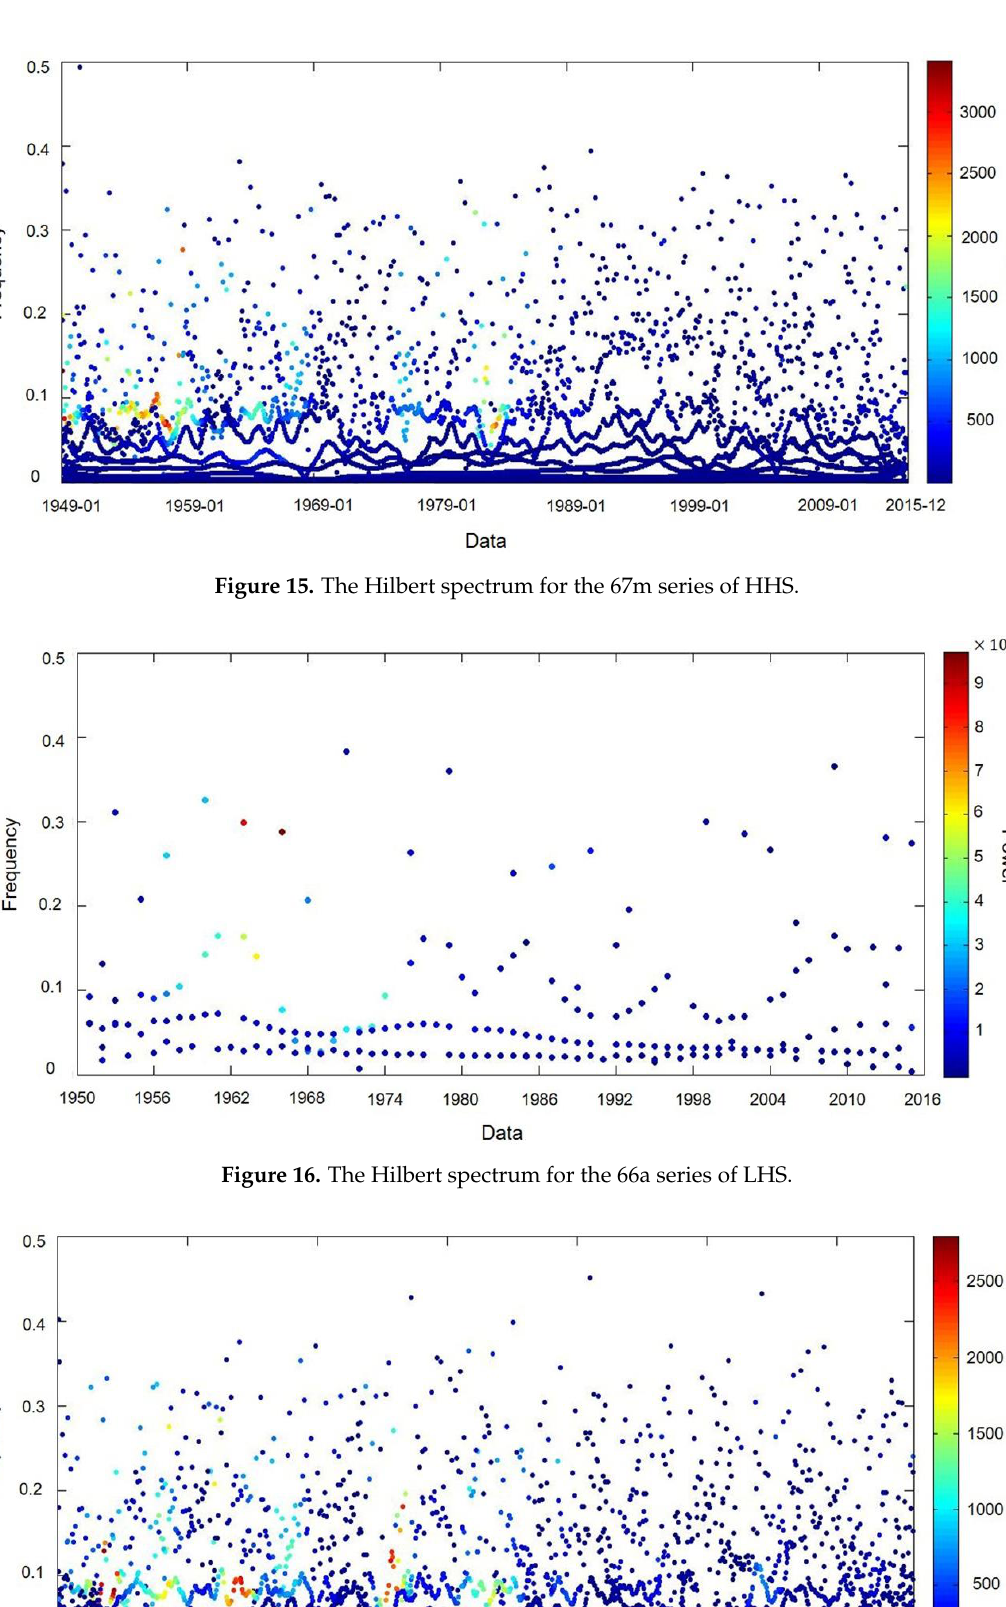
Figure 14. The Hilbert spectrum for the 67 a series of HHS.